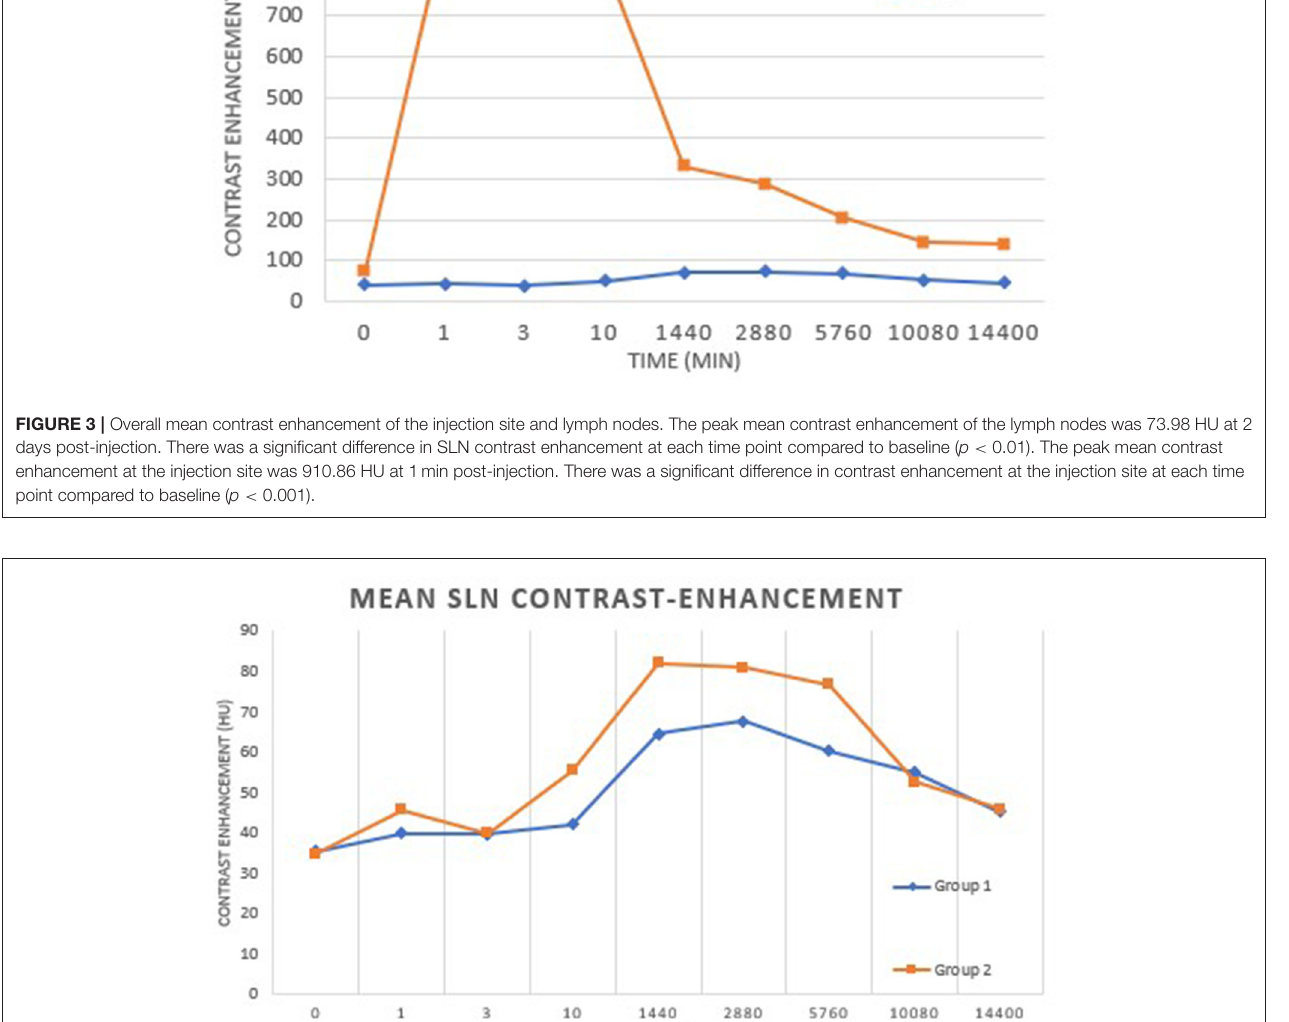
fluorescent lymph nodes was 96% up to day 4 p.i. compared